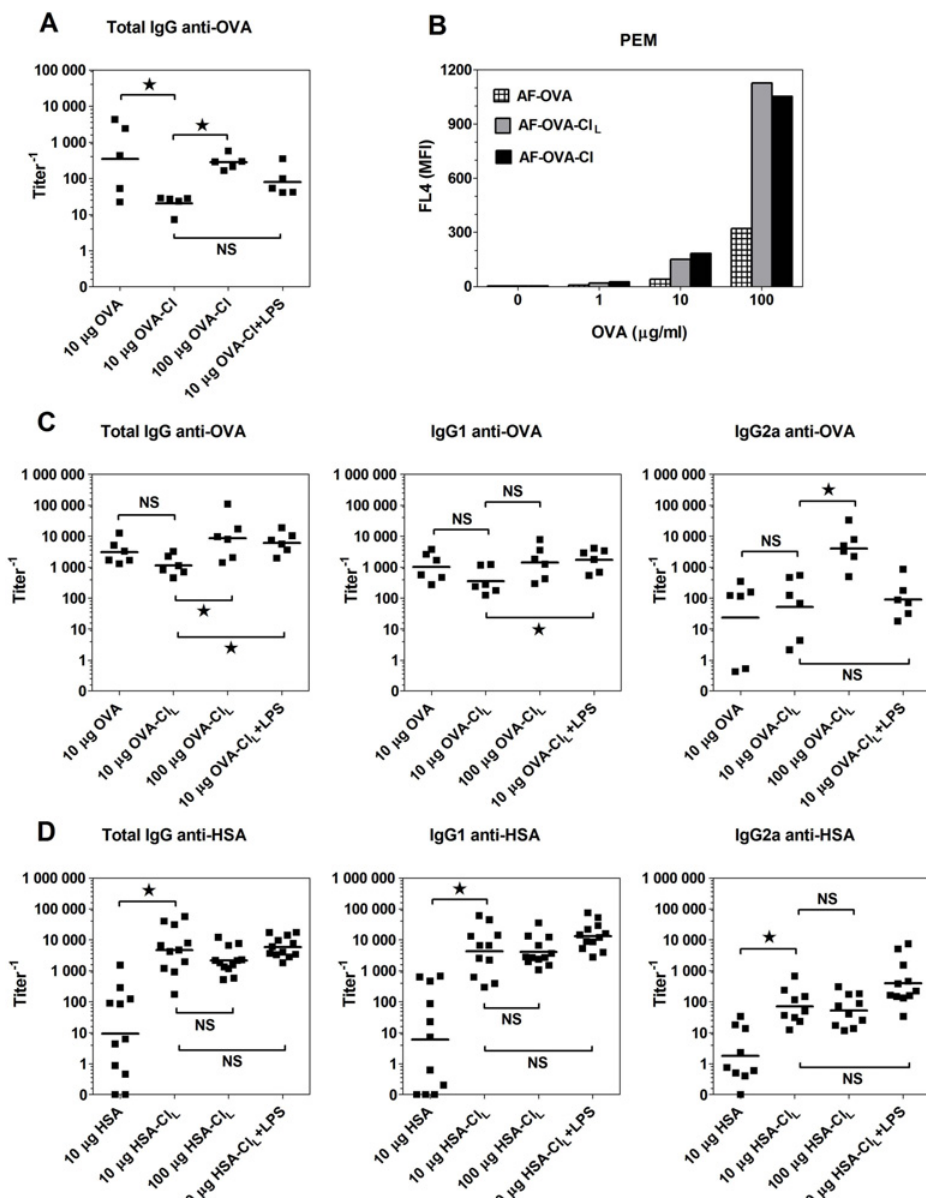
Fig 2. Humoral immune response stimulated by native and HOCl-oxidised proteins in vivo. ( A , C , D ) CBA mice were immunized with the indicated antigens. Two weeks later all mice received boost immunization with 20 μ g of native proteins and 8 days later sera were collected for the determination of titers of specific Ab by ELISA. Points represent titer values in individual mice and horizontal lines geometric means. ( B ) Uptake of fluorescently-labelled ligands by PEM was determined by flow cytometry. The data were analysed by ANOVA and the Benferroni post-test was applied to compare the indicated pairs of columns. * , p < 0.05; NS,